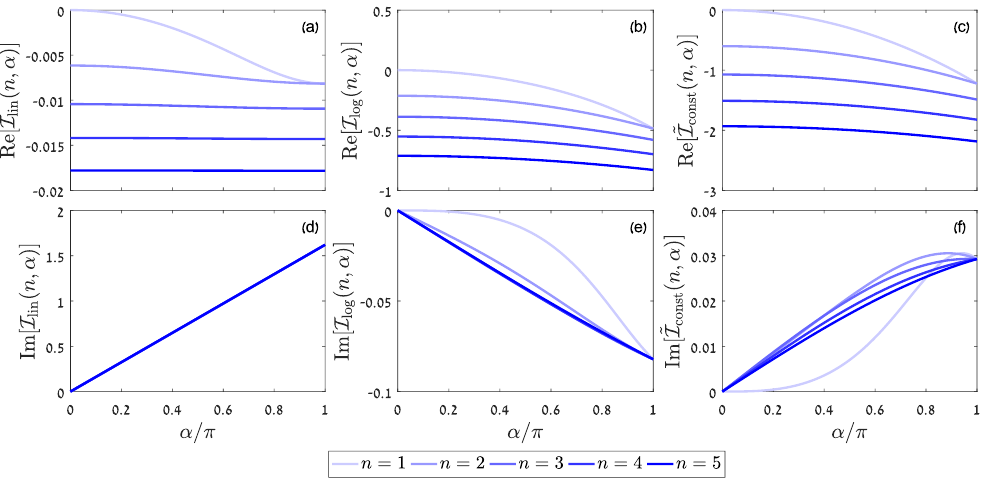
Figure 9: The single impurity model: Coefficients in the analytical asymptotic ex- ( α ) in Eq. (34), as a function of α for different fixed values of n . pression for ln Z n = t , k = π/ 2 and k − k = 0.1. The top The remaining parameters are set to ε F , R F , L F , R 0 panels (a)–(c) show the real parts of the coefficients, and the bottom panels (d)–(f) show their imaginary parts. Panels (a) and (d) are for the coefficient I , panels (b) lin and (e) are for I , and panels (c) and (f) are for ˜ I . Note that in panel (d) the log const ] is dominated by the first term in Eq. (27), different curves overlap because Im [ I lin which is independent of n